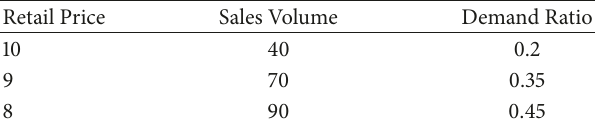
Table 2: An example of demand ratio 𝛼 𝑖